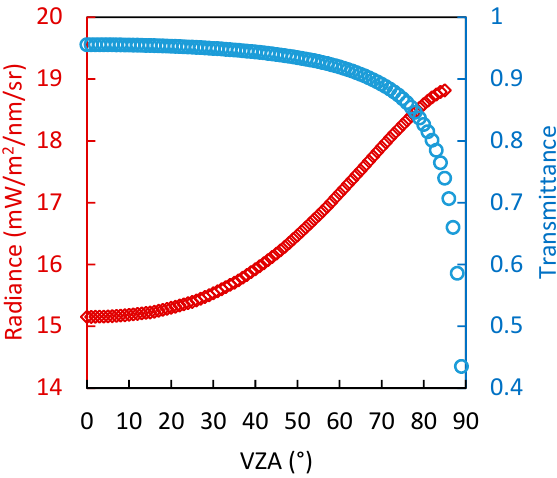
Figure 5. The variation of the up-welling radiance at top of canopy and atmospheric transmittance at 761.1 nm with the view zenith angle simulated by SCOPE and MODTRAN 5 models (Cab = 40 μ g/cm 2 , LAI = 4, LIDF is spherical). The spectral resolution is 0.3 nm, the view zenith angle is 0–89°, the relative azimuth angle is 90° and the sensor height above the target surface is 20 m.